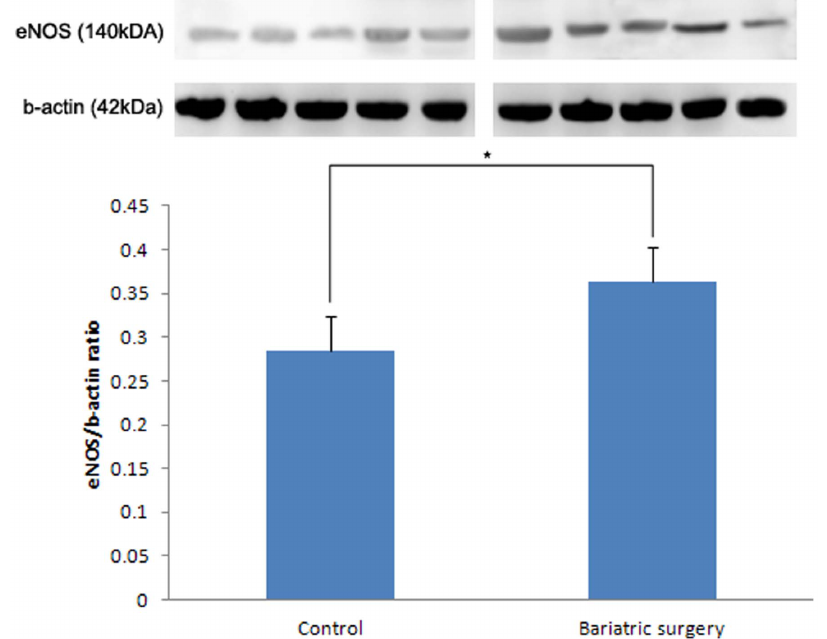
Figure 5. eNOS/b-actin ratio in the control and bariatric surgery groups (*: p=0.027).